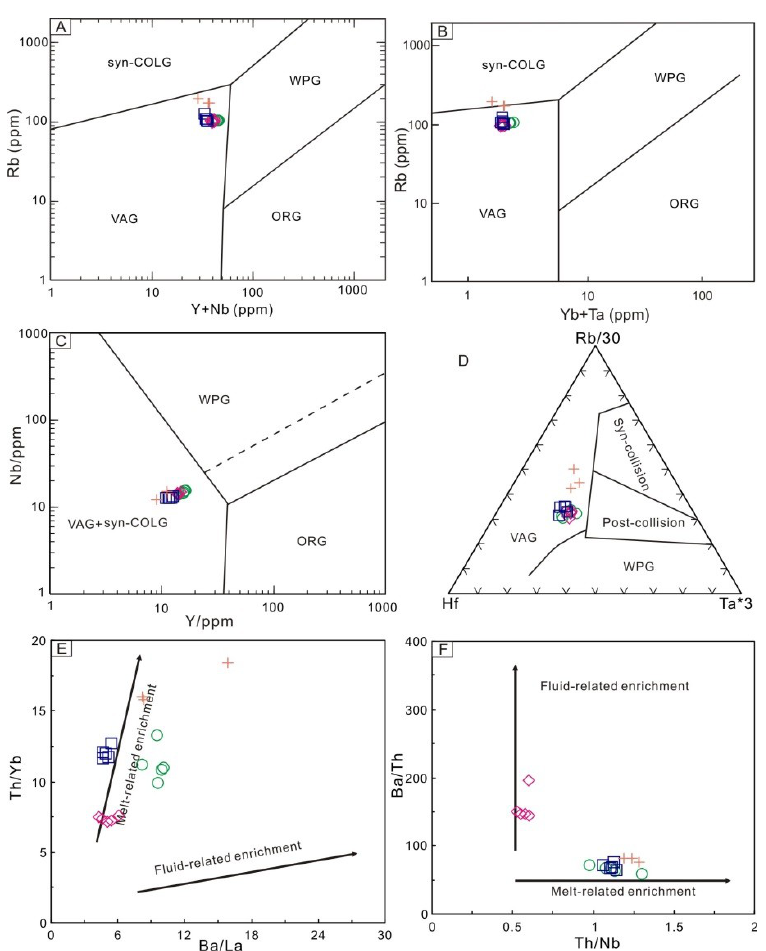
Figure 12. ( A ) Rb vs. Y + Nb (based on Pearce et al. [80]), ( B ) Rb vs. Yb + Ta (based on Pearce et al. [80]), ( C ) Y vs. Nb (based on Pearce [81]), and ( D ) Rb/30-Hf-Ta × 3 (based on Harris et al. [82]) tectonic discrimination diagrams for Pulang porphyry intrusions. ( E ) Th/Yb vs. Ba/La and ( F ) Ba/Th vs. Th/Nb diagrams showing the roles of the fluid- and melt-related enrichments of the source. Symbols are as in Figure 10.